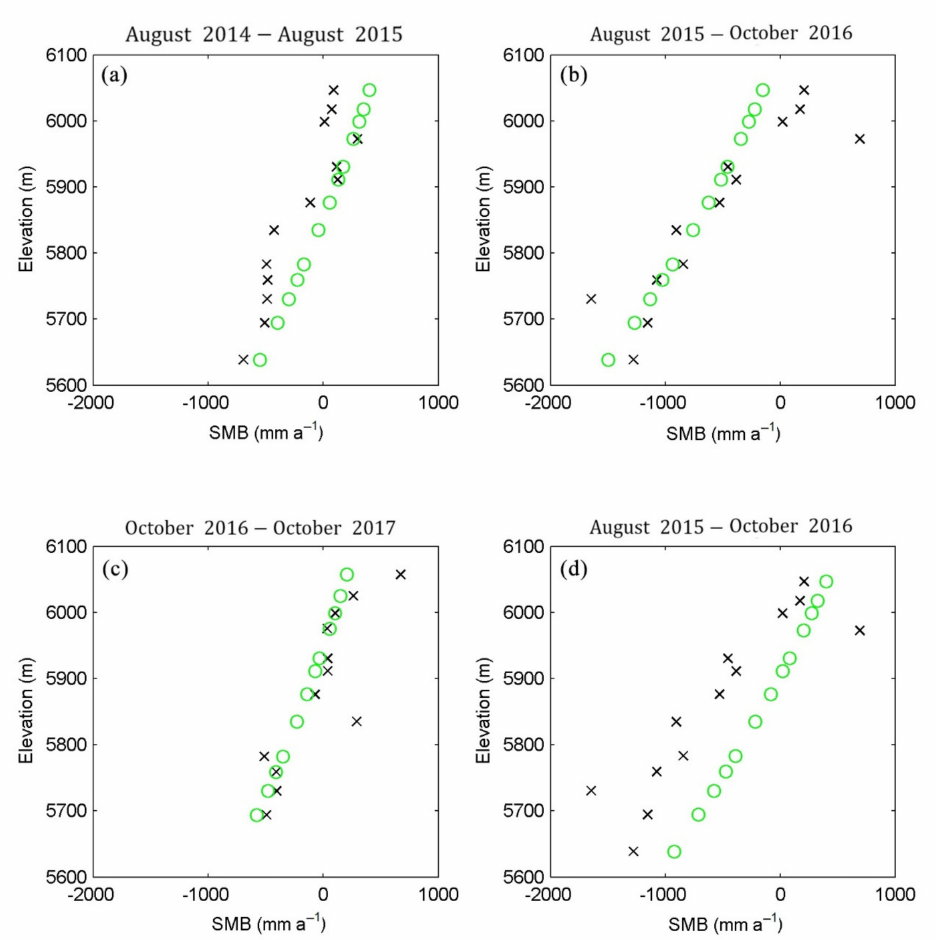
Figure 8. The observed SMBs (black crosses) compared with the estimate (green dots) using the best-fit precipitation gradients quadratic polynomial and DDF value of 3.4 mm · d − 1 ◦ C − 1 for the periods from August 2014 to August 2015 ( a ), from August 2015 to October 2016 ( b , d ), and from October 2016 to October 2017 ( c ). Plots ( a – c ) are based on the observed precipitation at the Shiquanhe station, and plot ( d ) is based on the observed precipitation at the